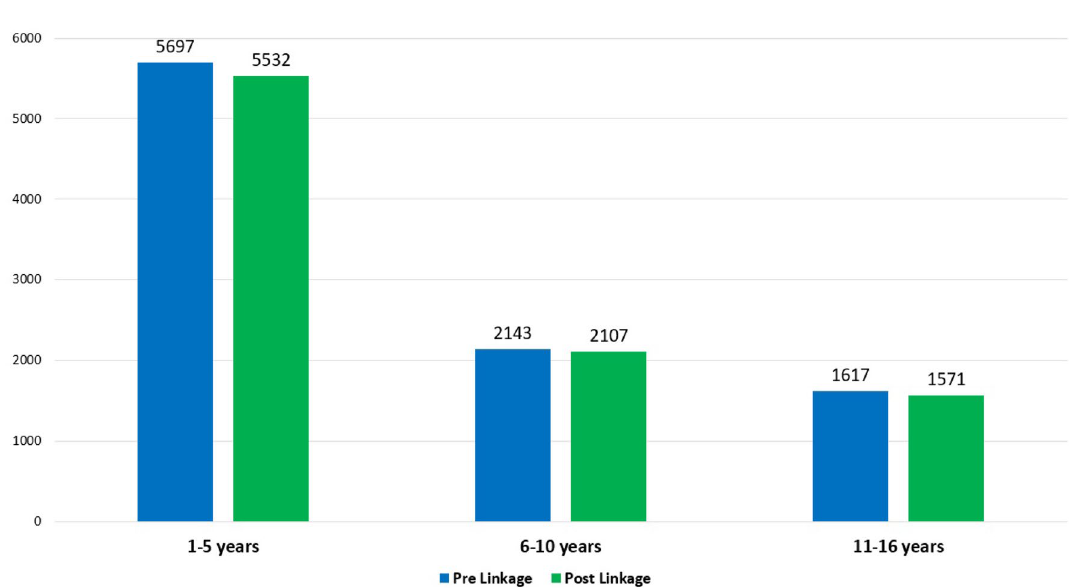
Figure 4. Comparison of the absolute number of lost follow-up times of patients pre- and postlinkage, categorized into the three groups